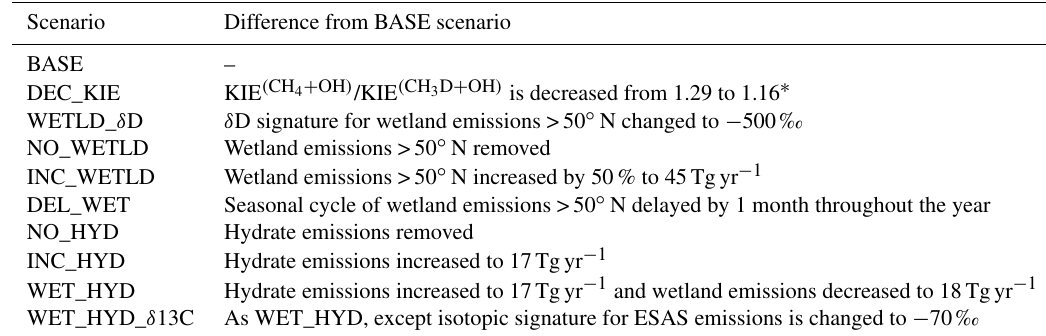
Table 2. A comparison of model scenarios and their differences from the BASE scenario. Scenario Difference from BASE